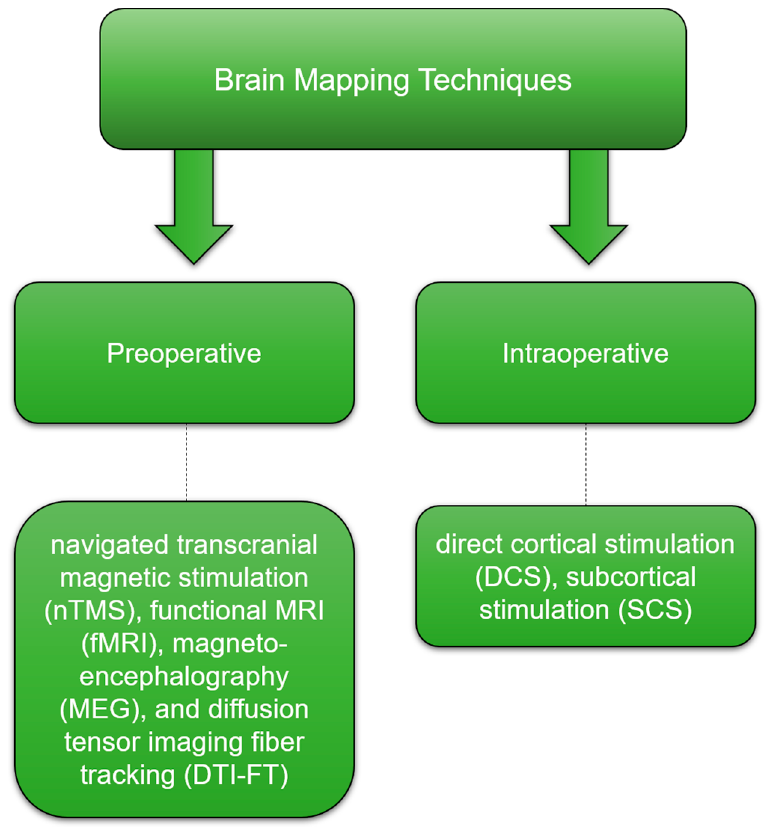
Figure 4. Brain mapping techniques.